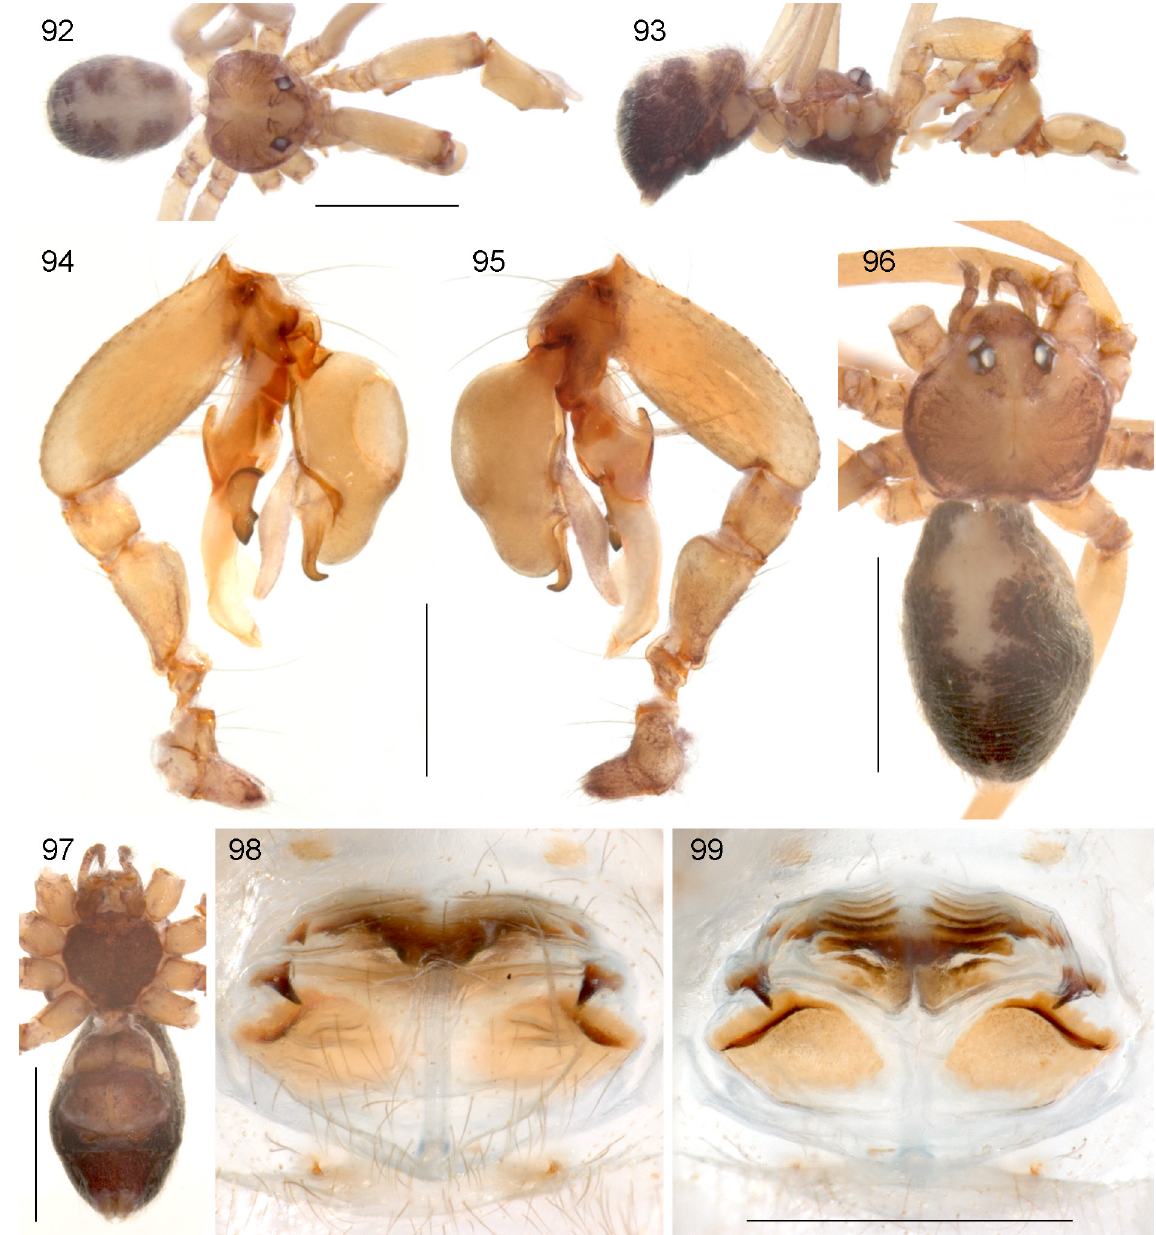
Figs 92-99. Spermophora ziama sp. nov. 92-93 . ♂, dorsal and lateral views. 94-95 . Left ♂ palp, prolateral and retrolateral views. 96-97 . ♀, dorsal and ventral views. 98-99 . Cleared ♀ genitalia, ventral and dorsal views. Scale lines: 92-93, 96-97 = 1 mm; 94-95, 98-99 = 0.5